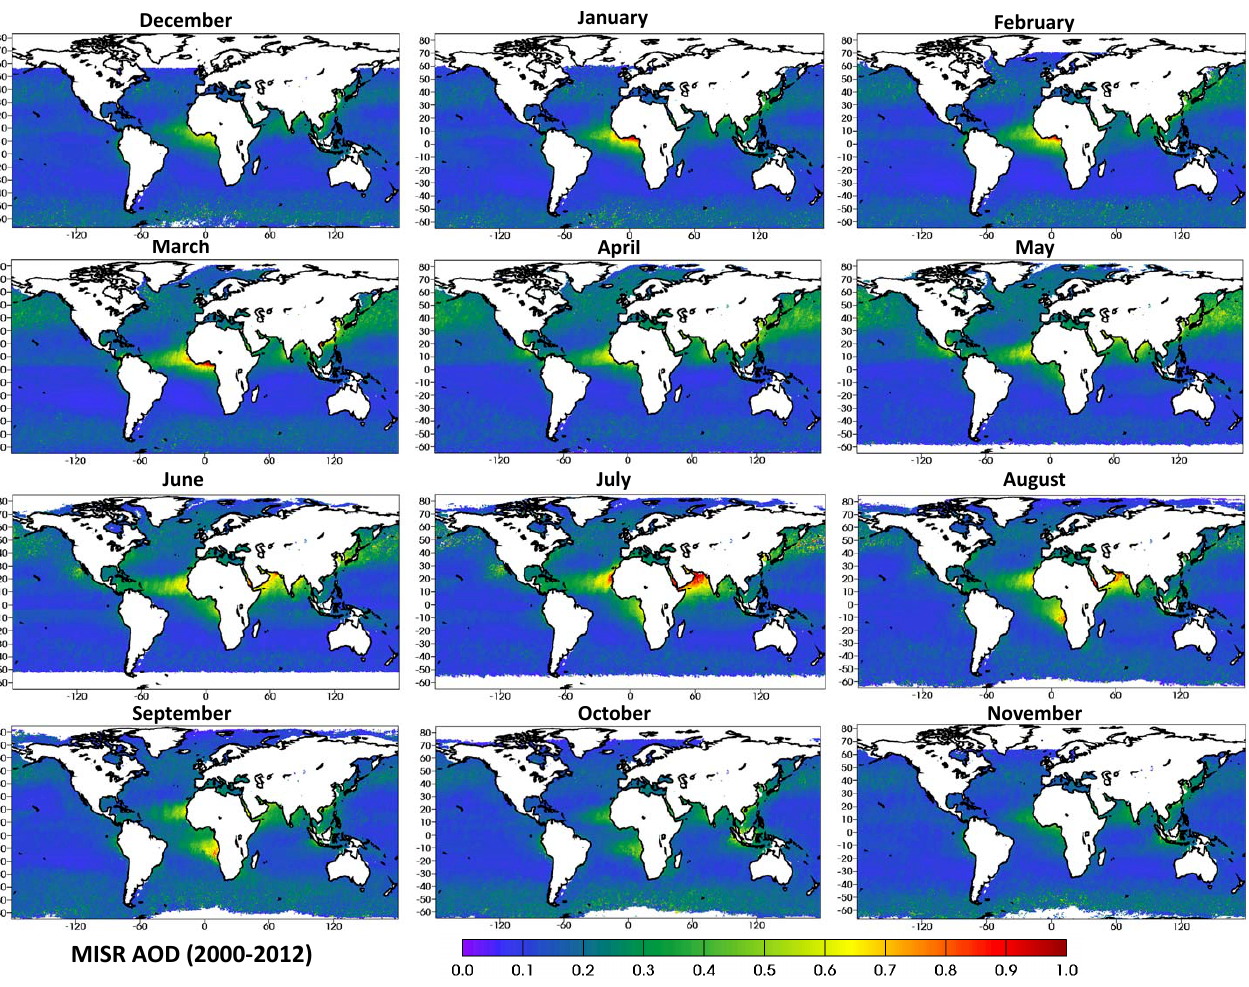
Fig. 3. Monthly climatology of MISR V22 green-wavelength AOD retrieved over dark water, averaged over 12 years: March 2000– February